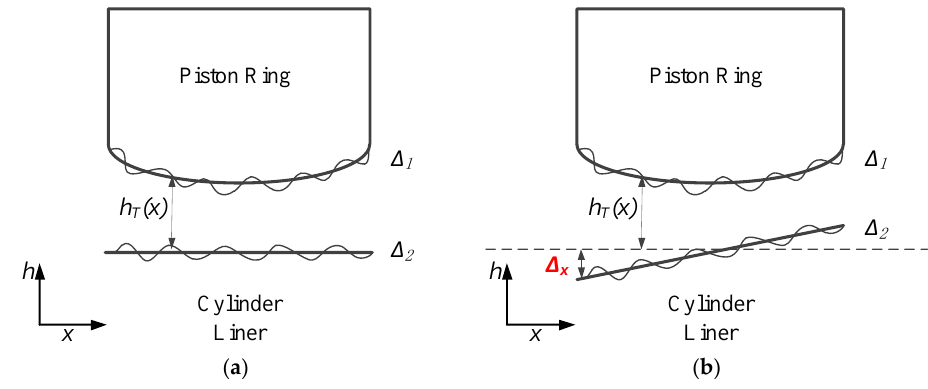
Figure 7. Rough piston ring and cylinder liner conjunction: ( a ) without liner deformation; ( b ) with consideration of liner deformation.